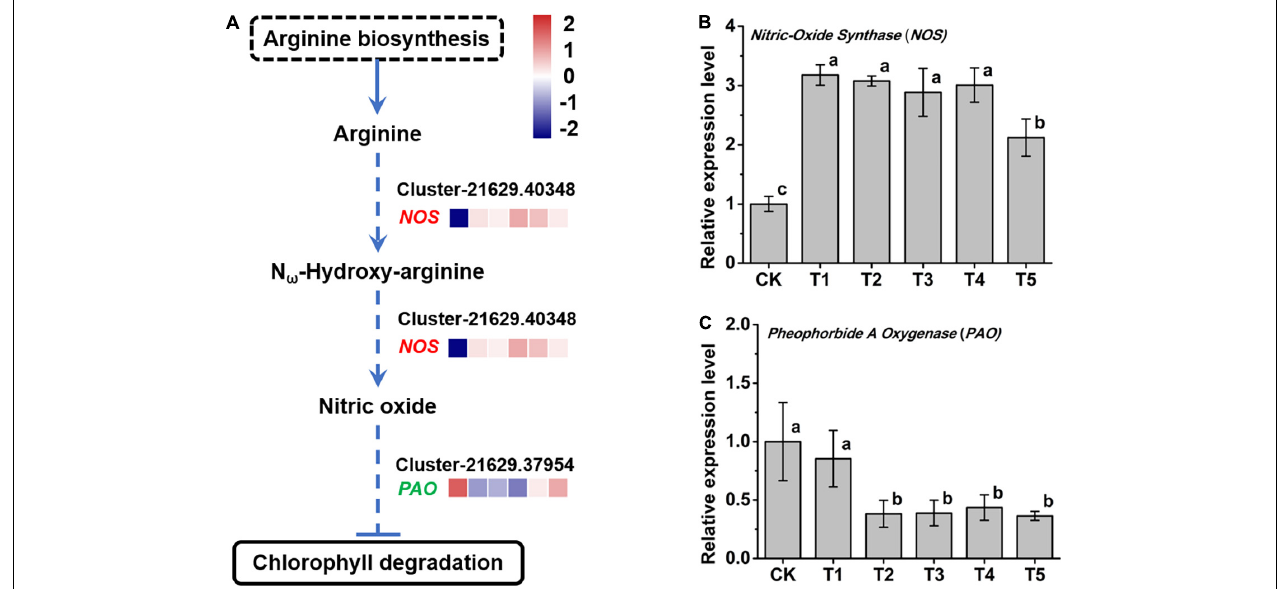
FIGURE 6 | The response of nitric oxide (NO) metabolism to freezing stress. (A) The biosynthesis pathway of NO was produced according to the KEGG database. (B) The expression of NOS , a NO synthase gene, was upregulated under freezing stress. (C) The expression of Pheophorbide a Oxygenase ( PAO ), a key gene in the Chl degradation pathway, was downregulated under freezing stress. The letters in (B) and (C) represent significant differences among the samples; Student’s t -test, p <